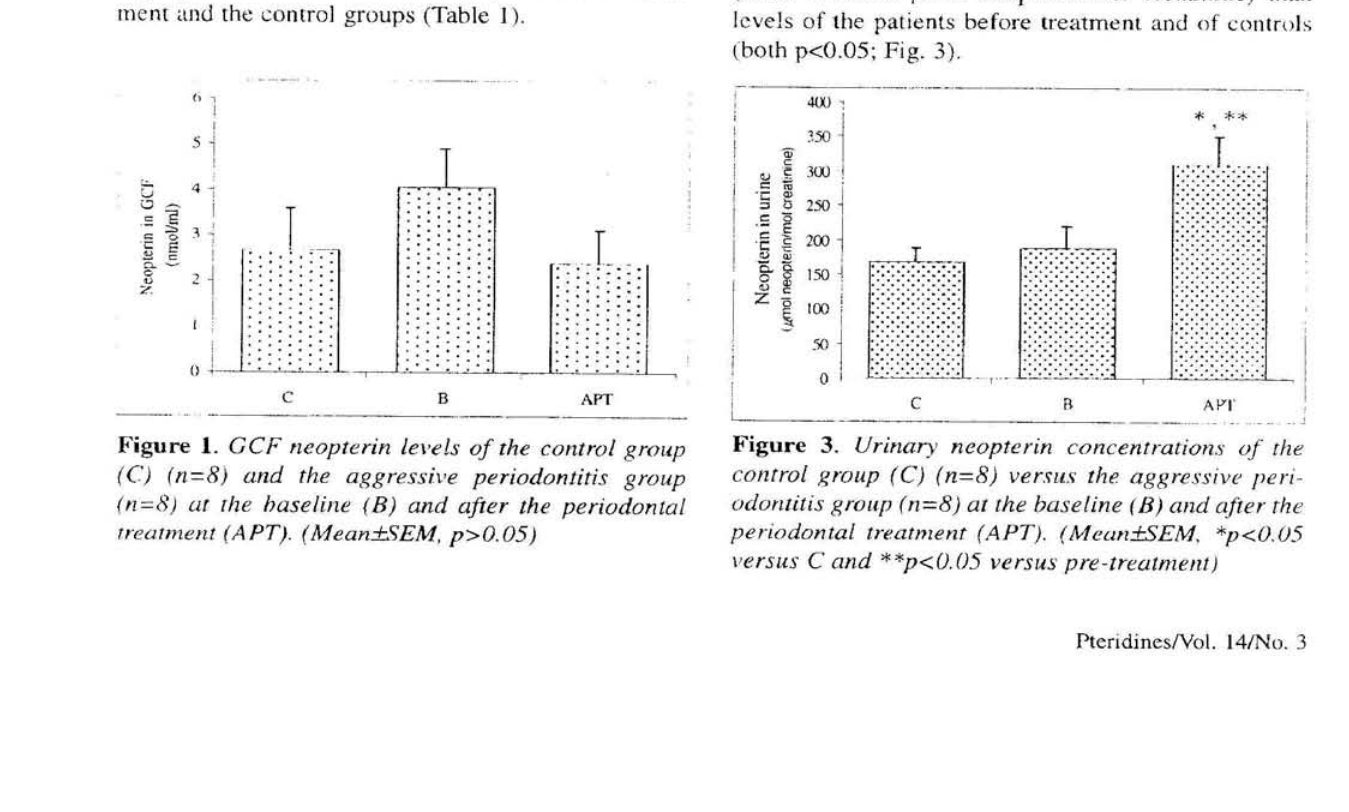
APT Figure 3. Urinary neopterin concentrations of the control group (C) (n=8) versus the aggressive peri- odontitis group (n=8) at the baseline (Β) and after the periodontal treatment (APT). (Mean+SEM, *p<0.ü5 versus C and **p<0.05 versus pre-treatment)